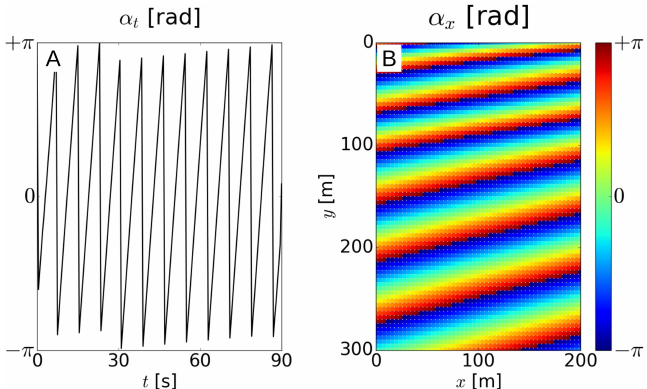
Figure 7. Angles α t ( A ) and α x ( B ) of the first PC and EOF corresponding to linear propagation of W1 for ∆ t = 0.5 s and ∆ x = 4 m: The explained variance is above 99%.